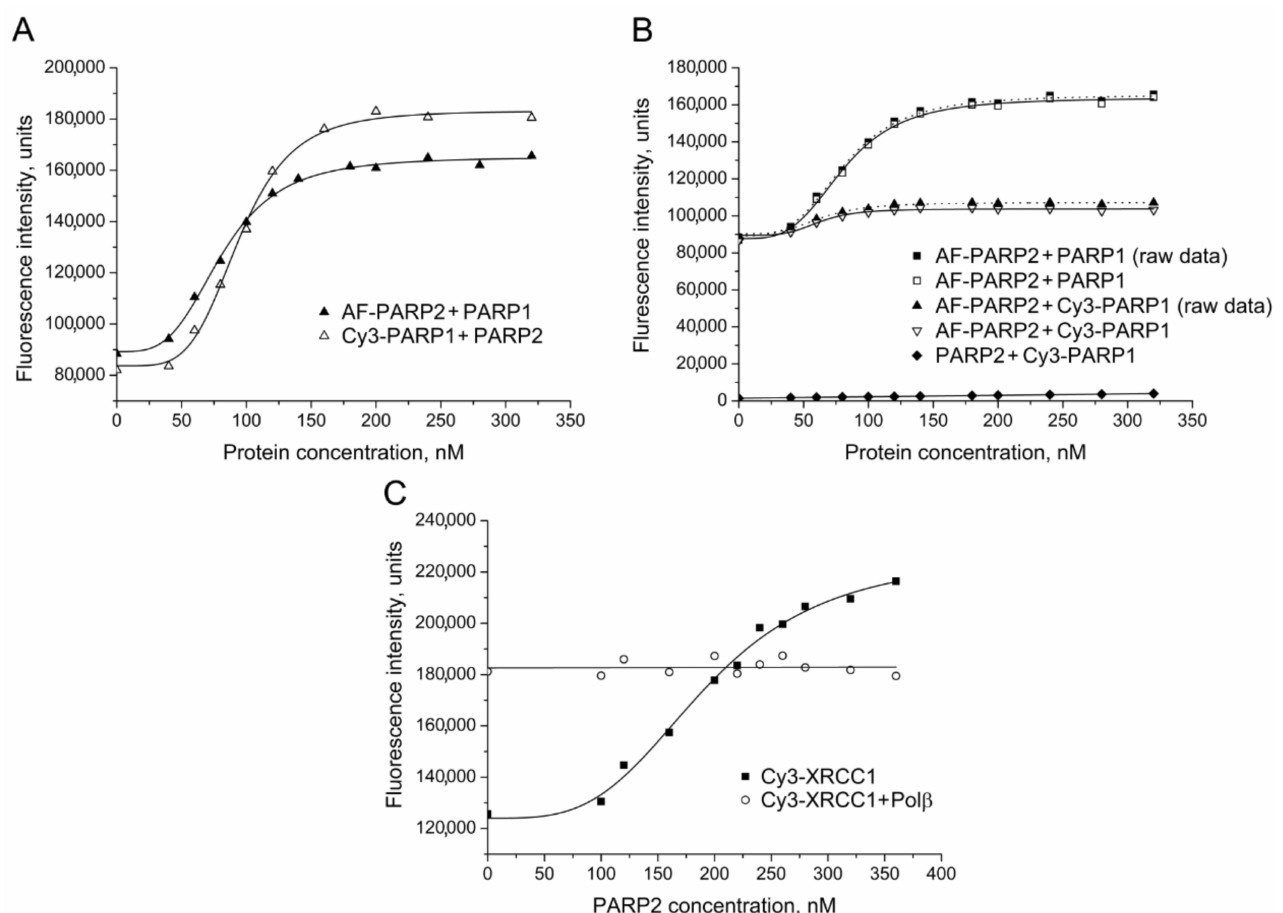
Figure 2. Detection of PARP2 interaction with PARP1 and XRCC1 by using AF and Cy3 as fluorophores. ( A ) Fluorescence titration of AF-PARP2 and Cy3-PARP1 (40 nM) with unlabelled PARP1 and PARP2, respectively. ( B ) FRET experiments were performed by titration of AF-PARP2 (40 nM) with unlabelled and Cy3-labelled PARP1. The efficiency of FRET was determined from the corrected data (open symbols) obtained from the raw data (filled squares and triangles) by subtraction of the background or Cy3 fluorescence intensities that were measured in control series by titration of unlabelled PARP2 with Cy3-labelled PARP1 (filled diamonds). ( C ) Fluorescence titration of Cy3-XRCC1 (40 nM) in the absence and presence of Pol β (200 nM) with PARP2 protein. Curves show the best fits of the four-parameter equation (with R 2 values exceeding